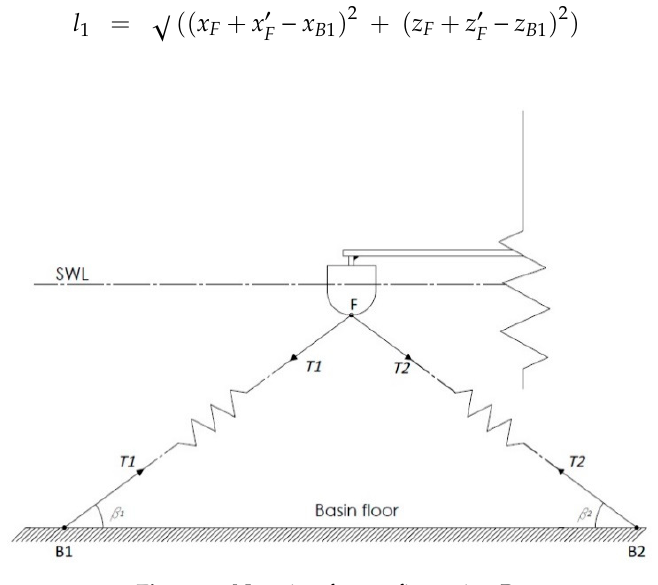
Figure 6. Notation for configuration B.